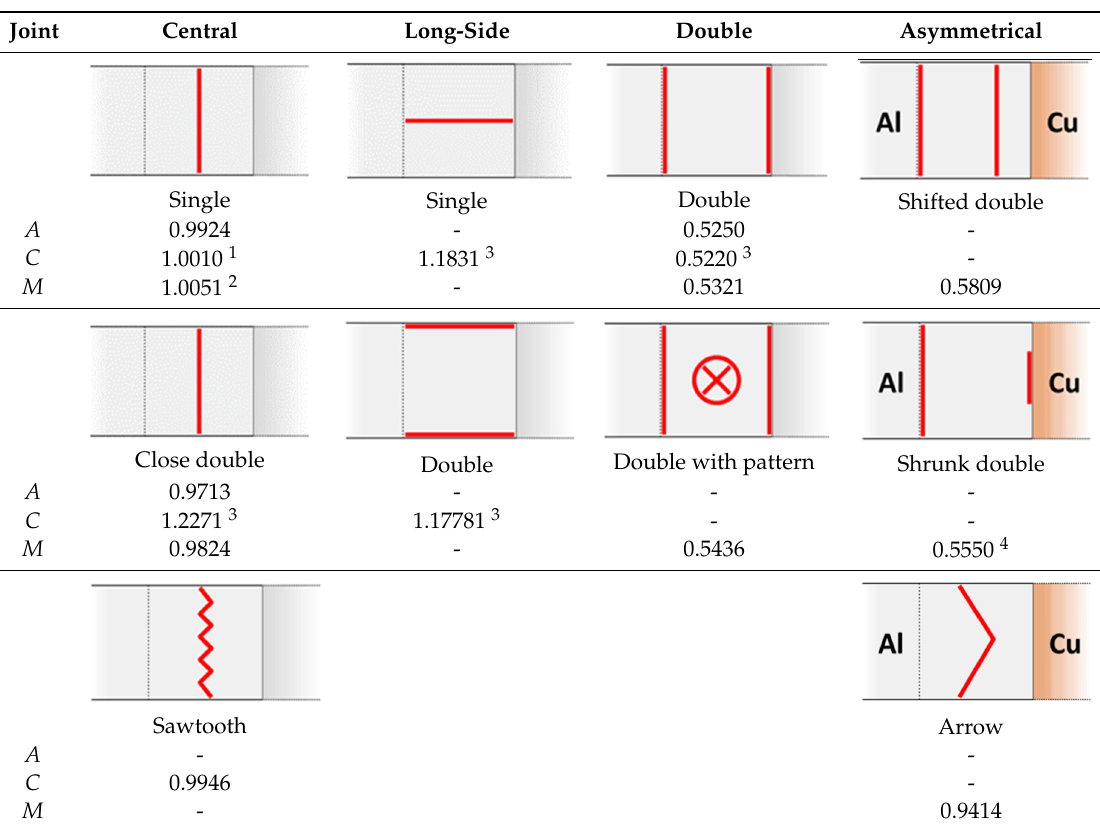
Table 1. CQIs of different weld geometries for Al–Al (A), Cu–Cu (C) and Al–Cu (M). Laser parameters: amplitudes A A = A C = A M = 0.2 mm unless specified; frequencies f A = f C = f M = 1 kHz; feed rates v f,A = v f,C = v f,M = 100 mm/s unless specified and power (on specimen) P A = 243 W, P C = 498 W, P M = 294 W.